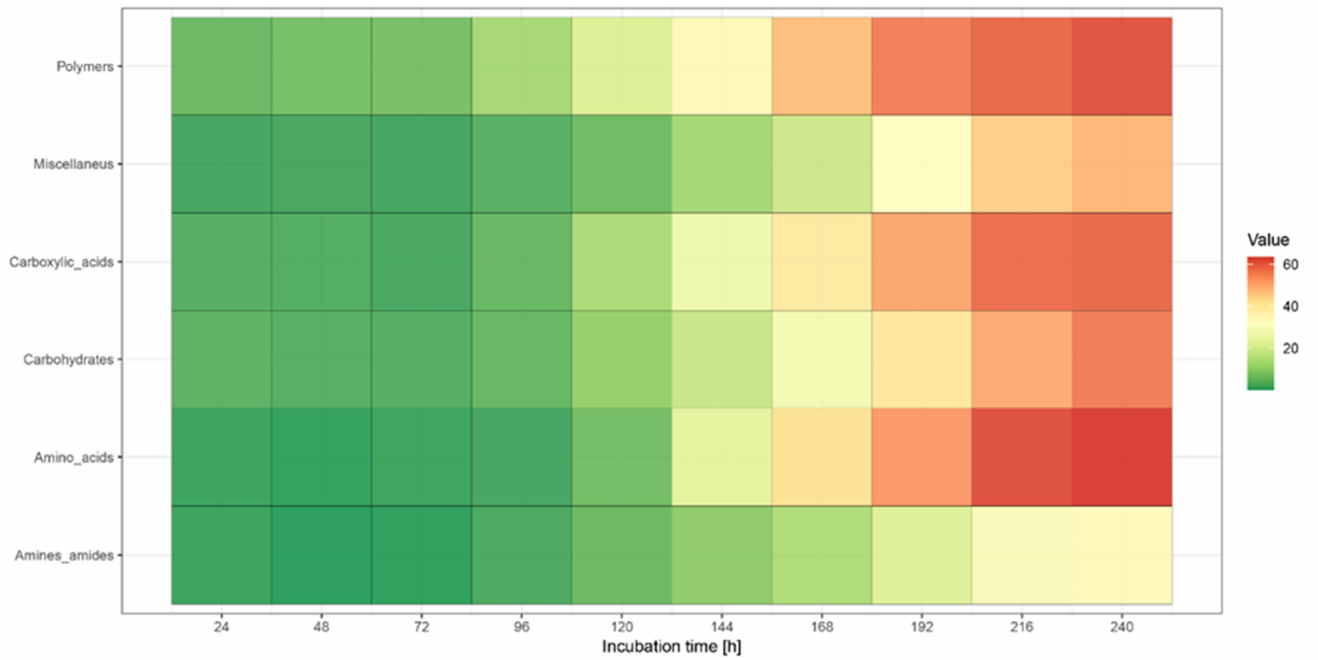
Figure 5. Heatmap presenting utilization of different groups of substrates by analyzed endophytic